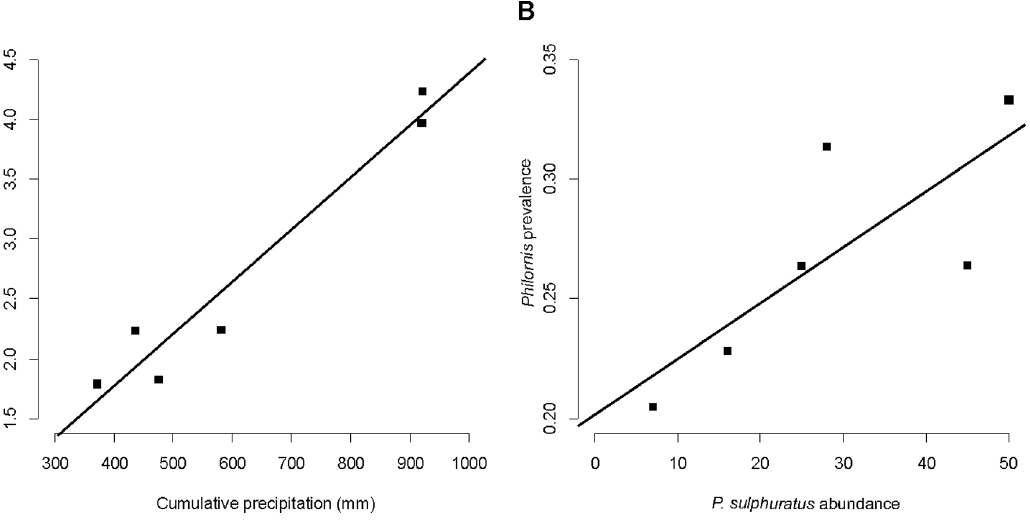
Figure 4. Interannual comparisons with data collected in 6 breeding seasons ( 2006–2012 ) . Correlation between A) precipitation fallen during the first two thirds of the breeding season and the mean Philornis abundance recorded that season; and B) number of P. sulphuratus nestlings present in one season and P. torquans prevalence in the whole community.